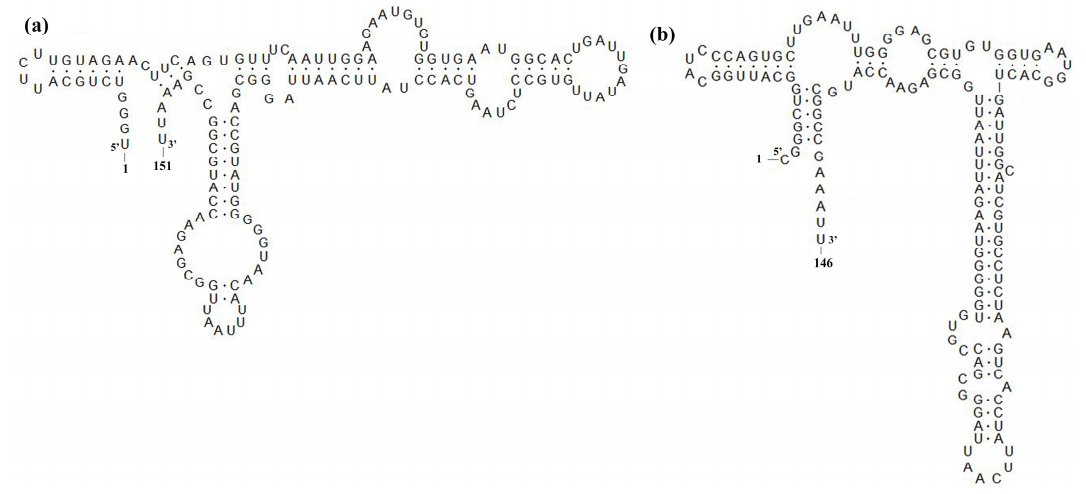
Figure 4. The predicted secondary structures of 3′-UTR sequences of SCcd16 ( a ) and SCya17 ( b ) are presented. The positions of the first and last nucleotide of both the 5′ and 3′-UTR are indicated. Schematic representation of secondary structures predicted by Mfold (http://mfold.rit.albany.edu/?q=mfold/RNA-Folding-Form) under default folding conditions and modified using RNAviz (http://rnaviz.sourceforge. net/).